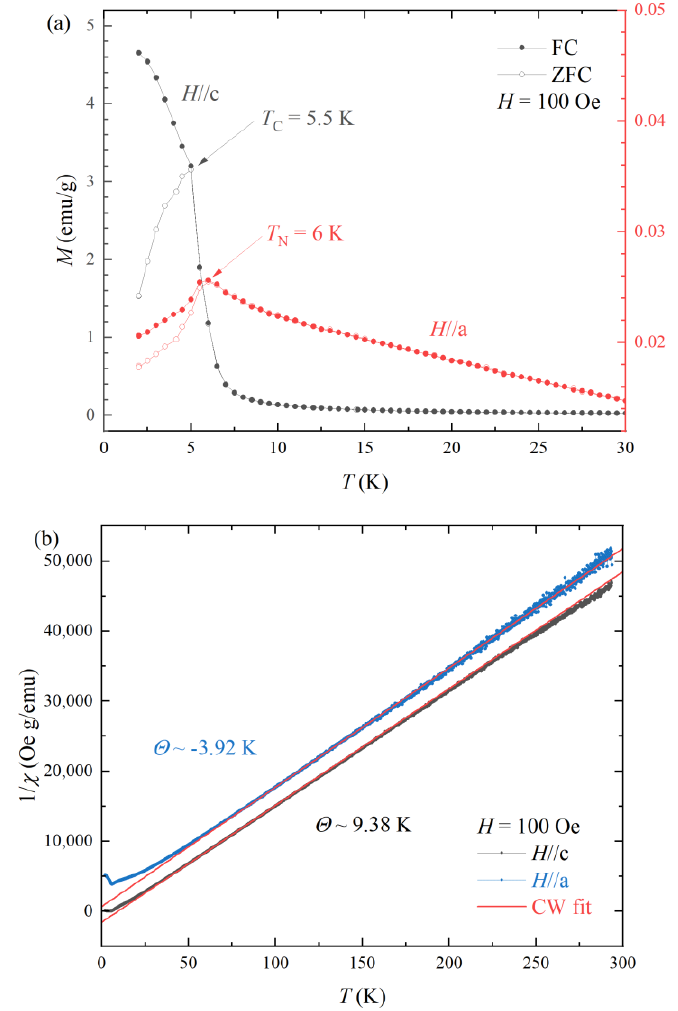
Figure 2. Temperature − dependent magnetization M(T) ( a ) and an inverse magnetic susceptibility 1/ χ (T) ( b ) with Curie − Weiss fit of NdAlGe. Figure 2b is the temperature-dependent inverse magnetic susceptibility χ −1 (T) of FC data with Curie-Weiss fitting (line) at high temperatures. The Weiss temperature along the H //c corresponds to the positive value θ = 9.38 K, while the one of H//a shows negative antiferromagnetic Weiss temperature θ = −3.92 K, implying that the ferromagnetic inter- action for H //c and antiferromagnetic interaction for H //a. The effective magnetic moment is estimated by μ eff = 2.94 μ B in both directions of H //c and H //a, which is in between those values of ionized Nd 2+ = 2.68 μ B and Nd 3+ = 3.62 μ B , implying a possible mixed valence state of Nd 3+ and Nd 2+ . The possible mixed valence state can be investigated as further research. The ferromagnetic nature is also observed in the isothermal magnetization with mag- netic field M ( H ), as presented in Figure 3a. For the zero-magnetic field limit, the remanent magnetization is 0.9 μ B at T = 2 K for H //c. Notably, there is a broad increase of magneti- zation over a broad range of H = 1 ~ 3 T and saturates to 2.75 μ B . The saturation magneti- zation is also in between the values of Nd 2+ 2.4 μ B and Nd 3+ 3.27 μ B . The broad increase of magnetization is considered by a slowly varying spin reorientation. The remanent mag- netization 0.9 μ B at a low magnetic field is 1/3 of the saturation magnetization 2.75 μ B .